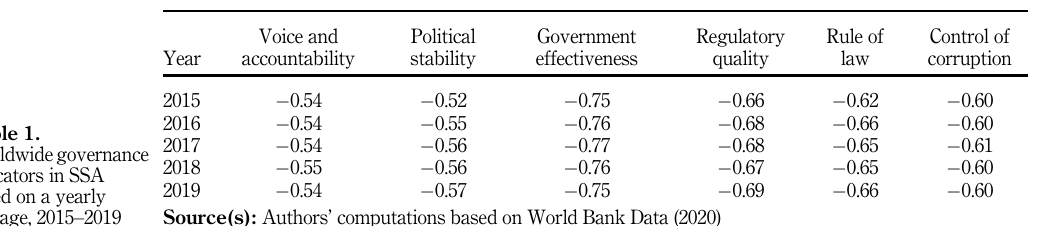
Table 1. Worldwidegovernance indicators in SSA based on a